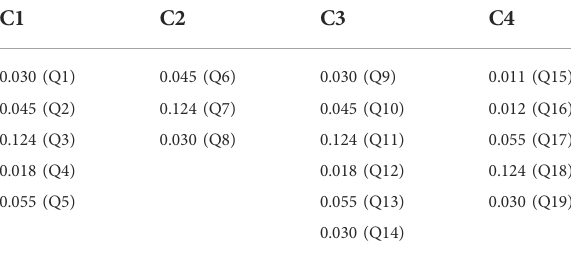
TABLE 3 Average random consistency index RI standard value.